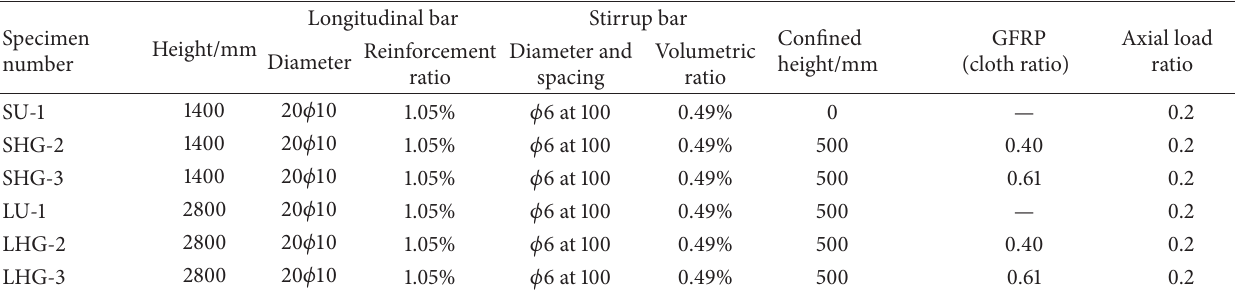
Table 1: Properties of the bridge pier